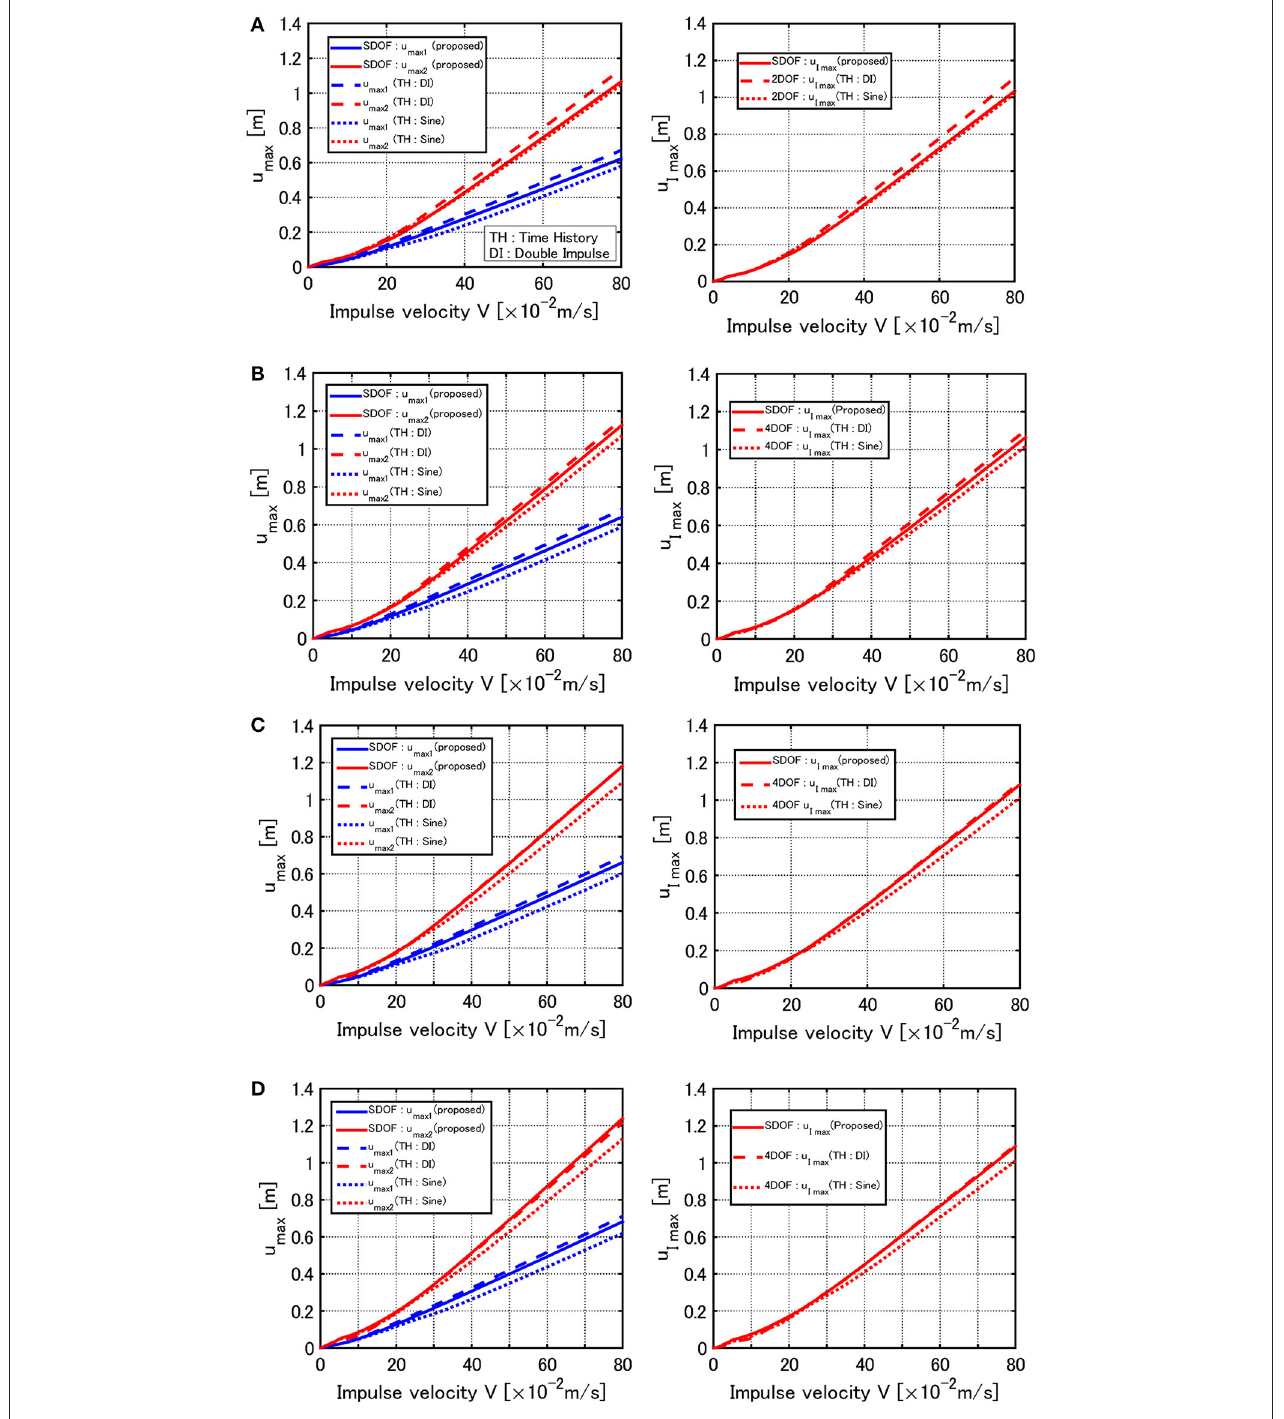
FIGURE 10 | Comparison of maximum deformations of 10-story model for the proposed method, time-history response analysis under double impulse and time-history response analysis under corresponding one-cycle sine wave, (A) Rigid ground, (B) Soil type 1, (C) Soil type 2, (D) Soil type 3.